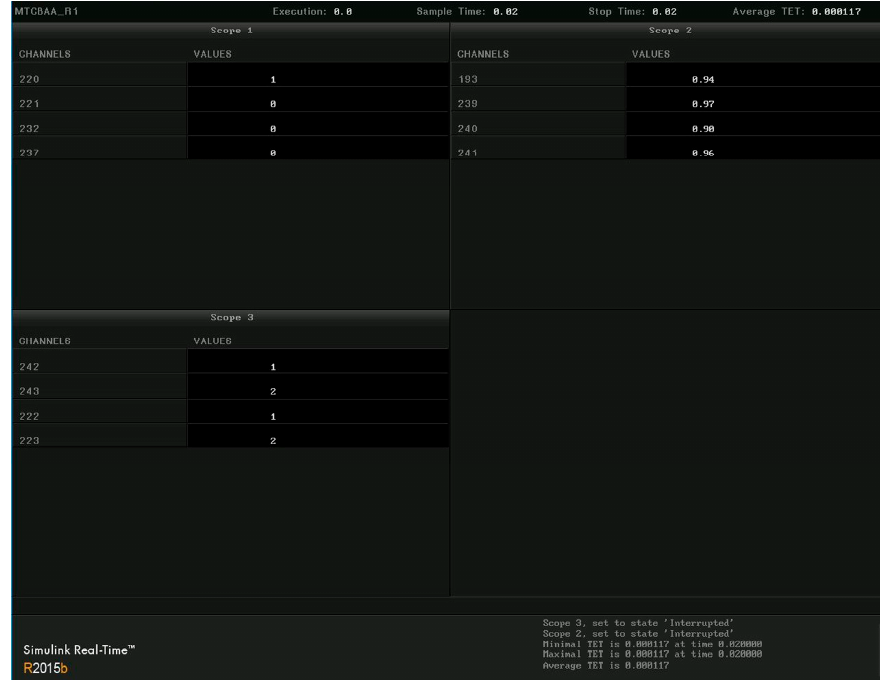
Figure 6. The xPC GUI of target computer 1.